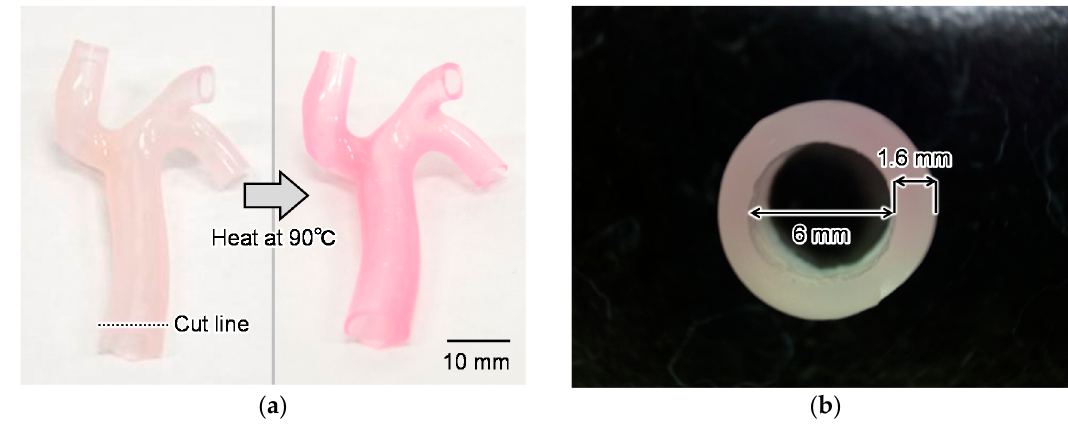
Figure 5. Fabricated blood vessel model with temperature-indicating function. ( a ) The vessel model before and after heating at 90 °C; ( b ) Cross-sectional view of the model cut along the cut line in ( a ).